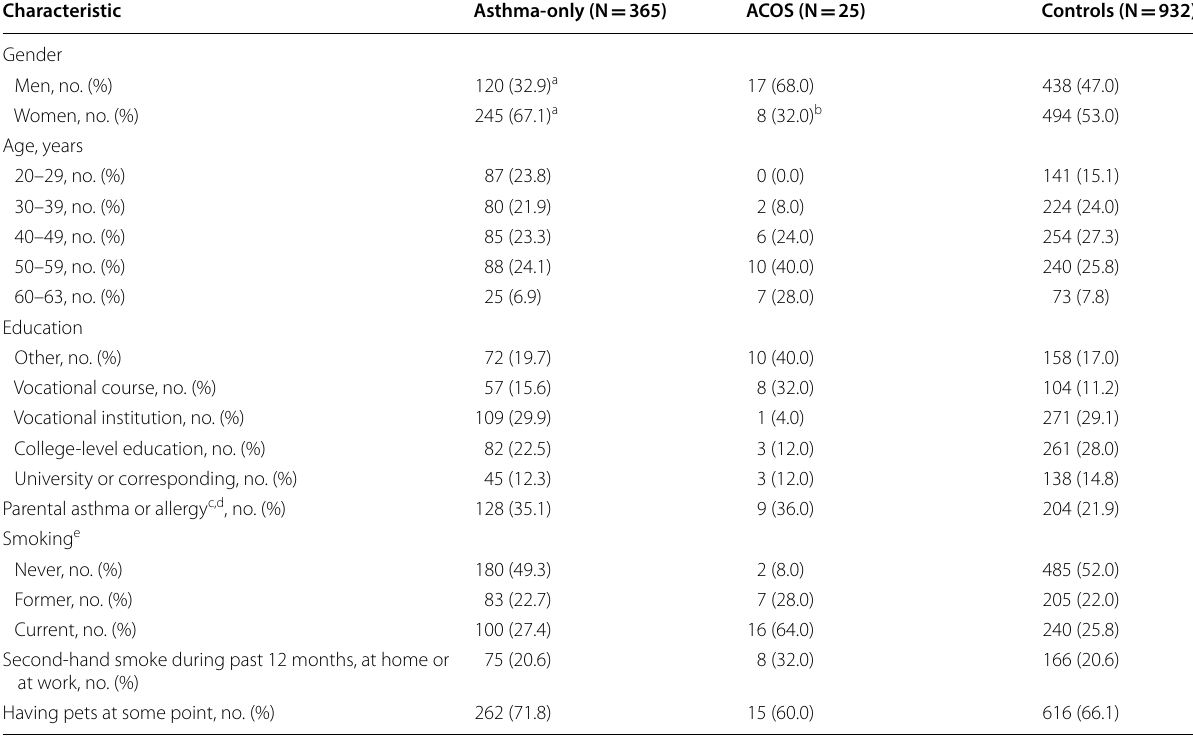
Table 1 Characteristics of Asthma-only and ACOS cases and population-based controls, the Finnish